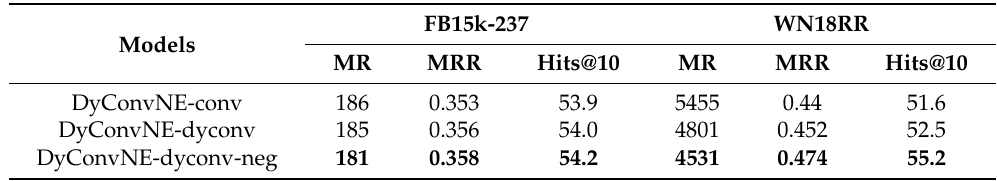
Table 9. The result of ablation study on FB15K-237 and WN18RR test sets. Hits@10 values are in percentage. The best score is in